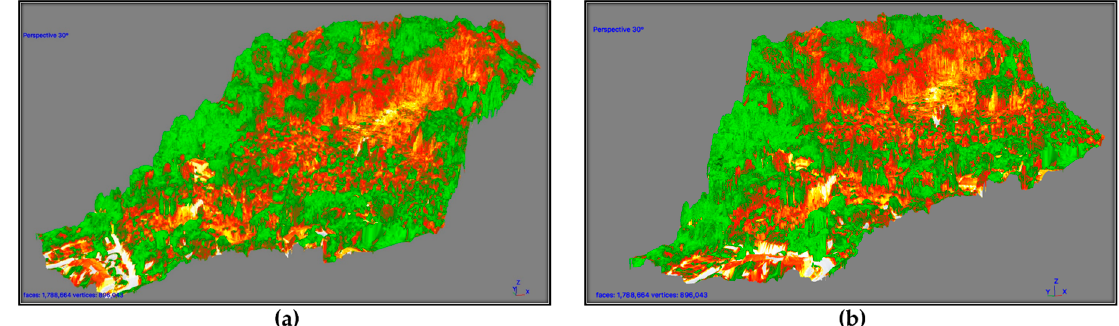
Figure 17. Photoscan 3D mesh of the area with computed NDVI index. ( a ) S view; ( b ) S-W view.